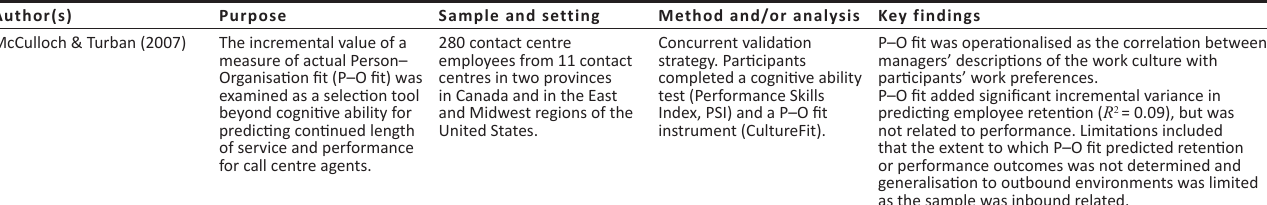
TABLE 2: Person–environment fit.